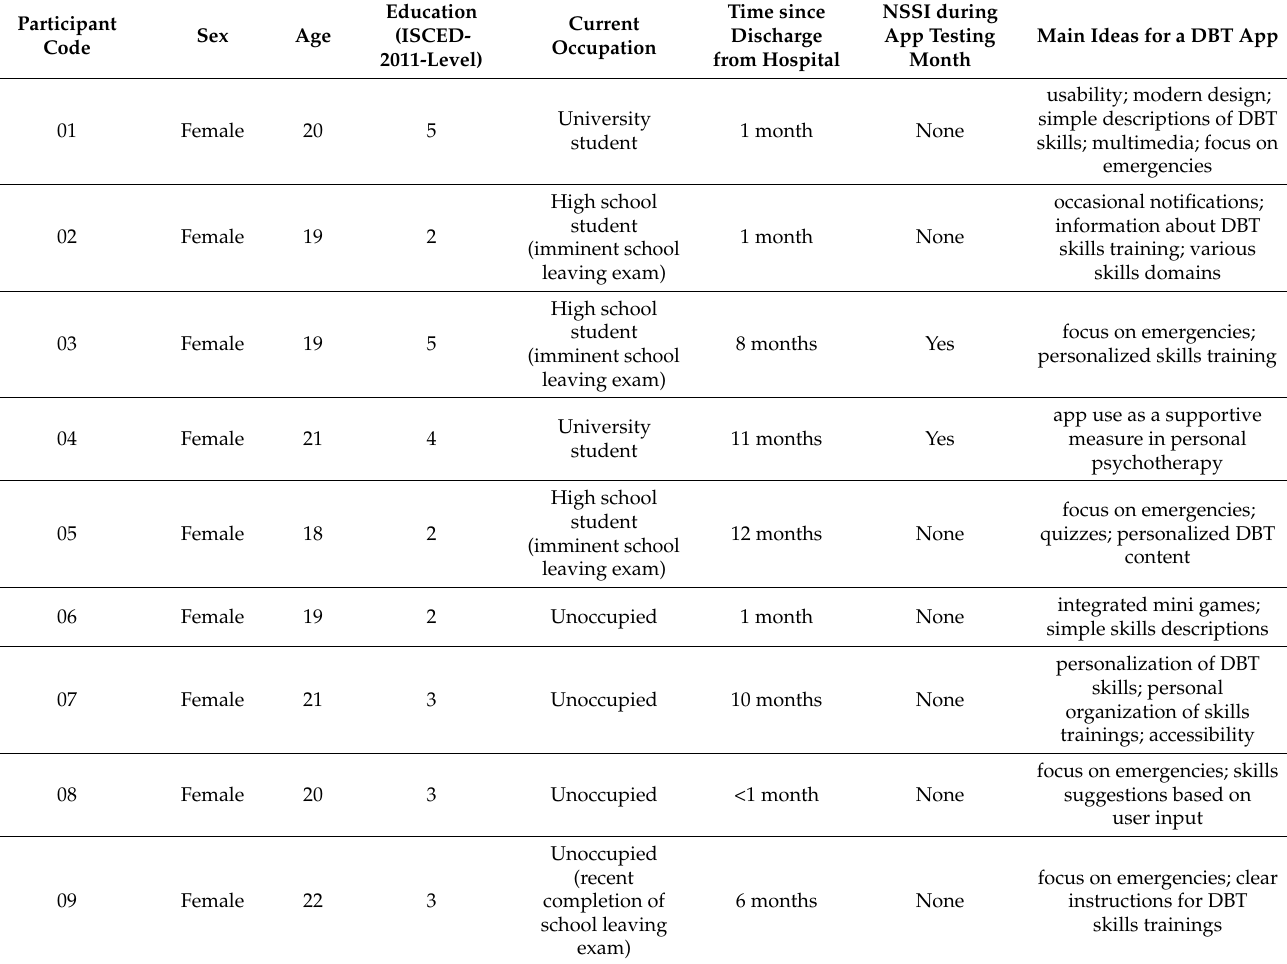
Table 2. Transitional age youth (TAY) participants with borderline personality disorder (BPD), based on sex, age, education level, current occupation, time since discharge from hospital, occurrence of NSSI during the app testing month, and ideas for an effective DBT-based